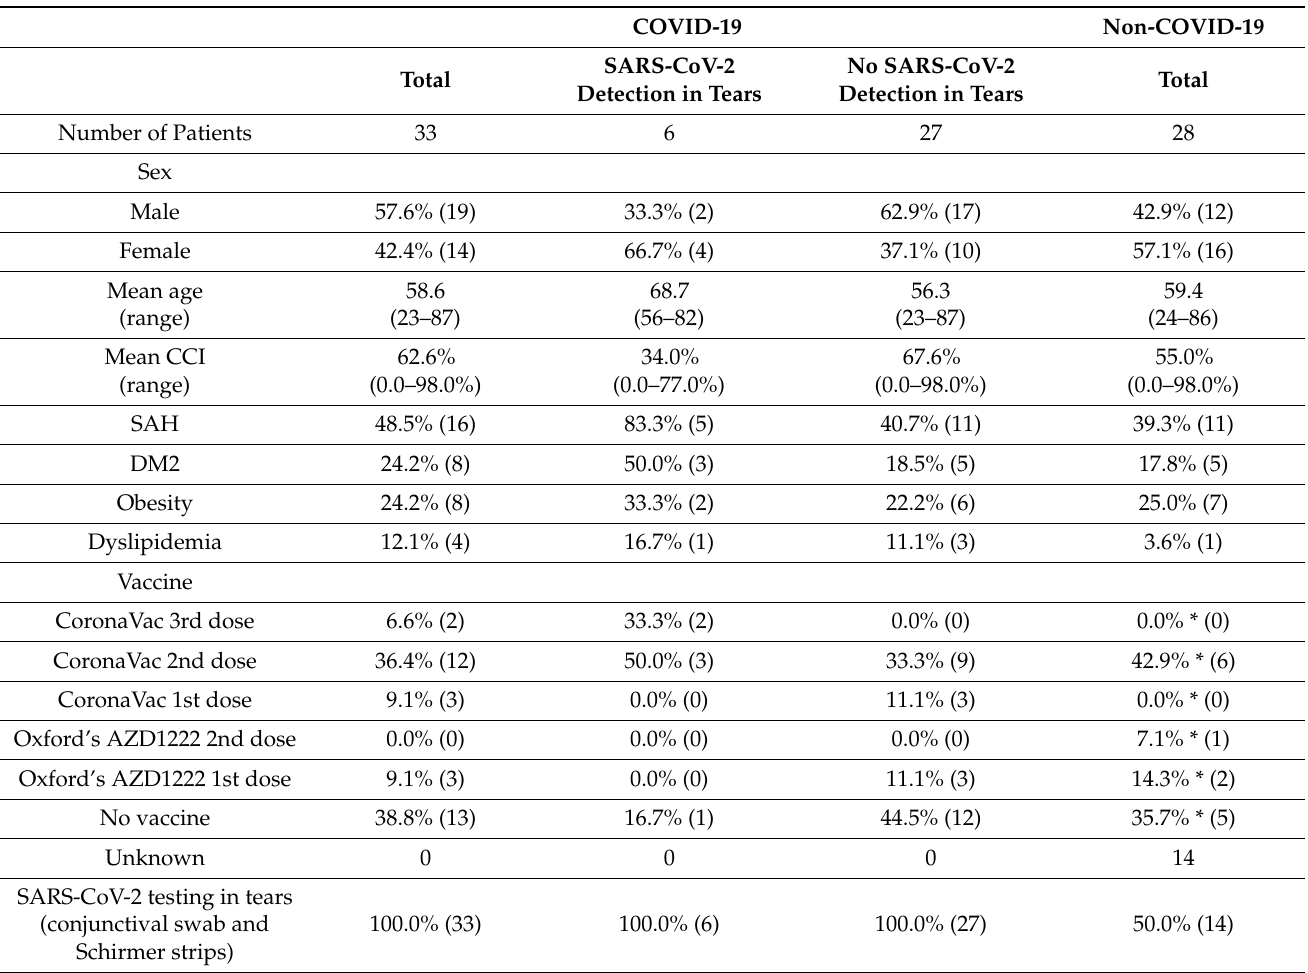
Table 1. Patients’